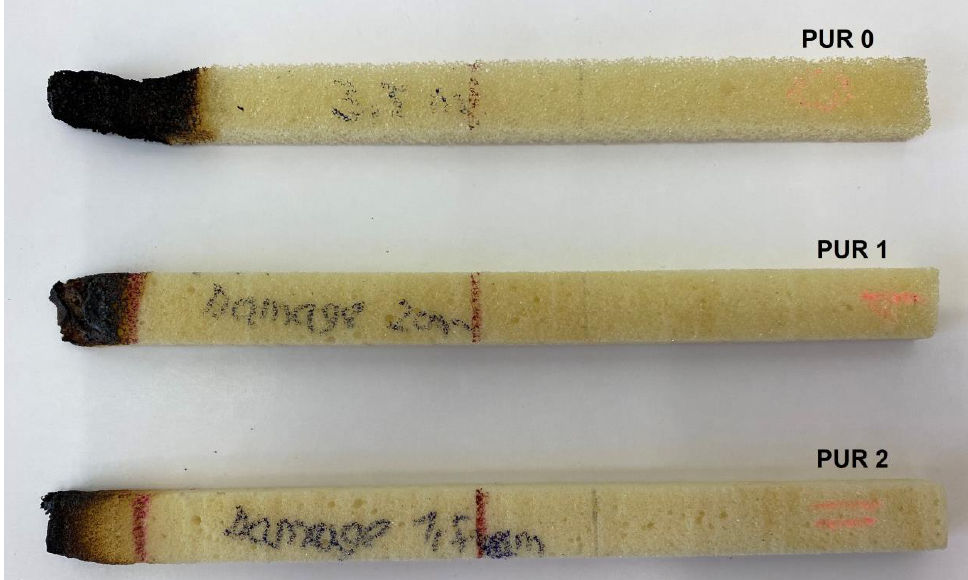
Figure 4. Visual differences between PUR 0, PUR 1, and PUR 2 after the UL-94 HB burning